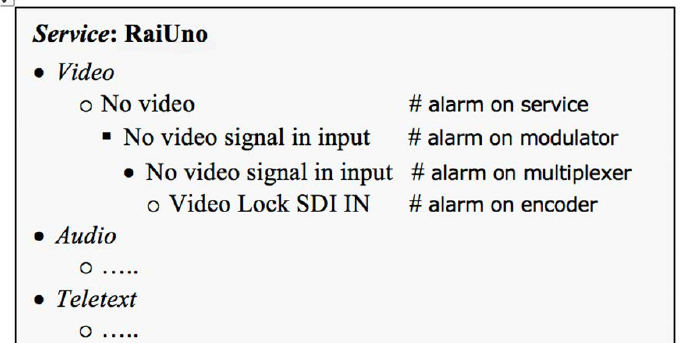
Figure 13. Example of an alarm tree. Appl. Sci. 2021 , 11 , x FOR PEER REVIEW